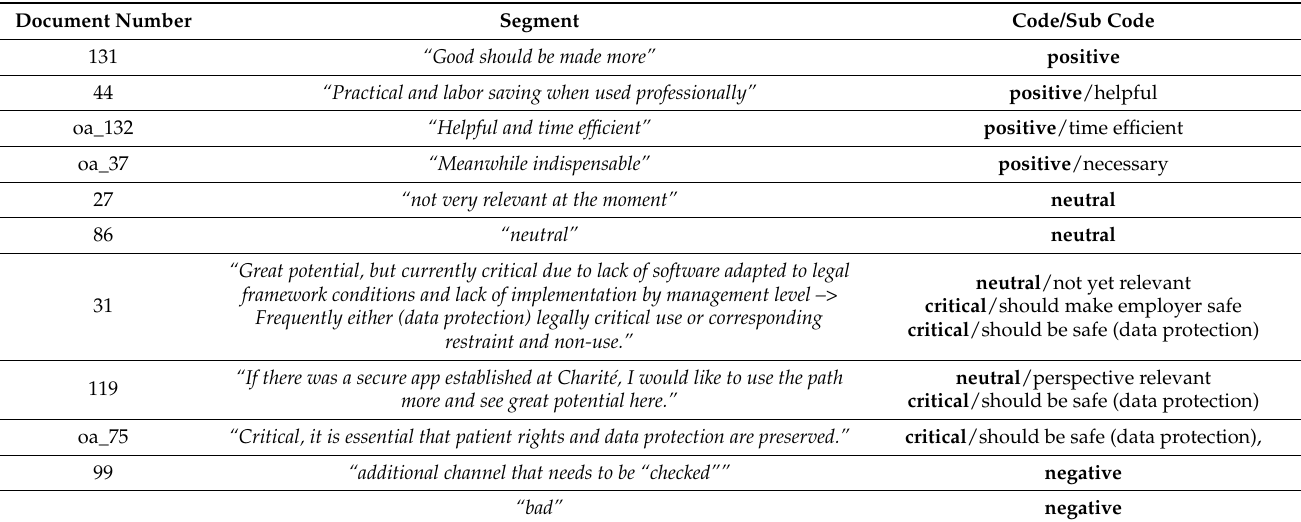
Table 4. Example segments with assigned codes (Q18) “How do you evaluate the use of communica- tion apps in everyday hospital